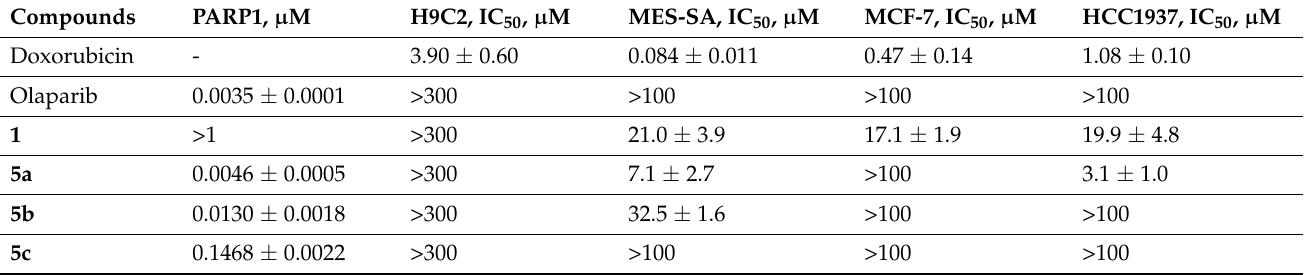
Table 1. PARP1 inhibiting activity and cytotoxicity of 5a – c on H9C2, MES-SA, MCF-7, and HCC1937 cell lines.